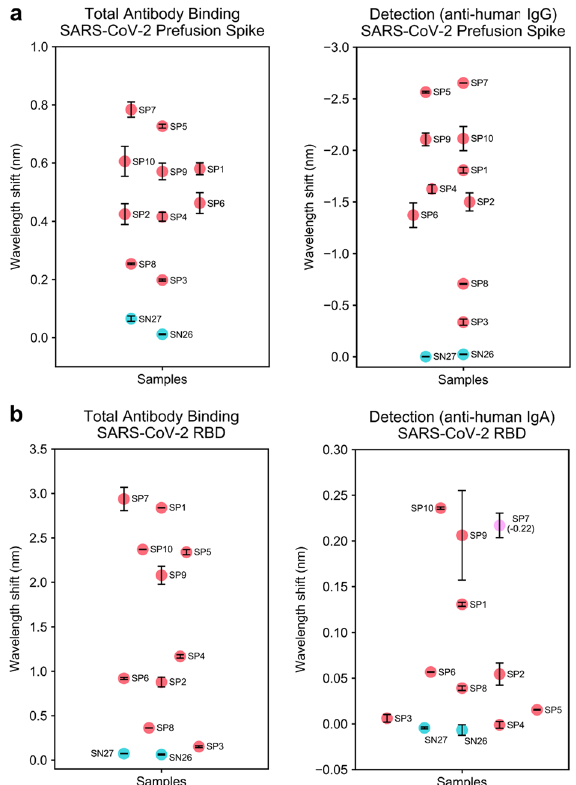
Figure 4. BLI-ISA evaluation of plasma antibodies to SARS-CoV-2 prefusion Spike and plasma IgA to SARS- CoV-2 spike RBD. ( a ) Single-dilution BLI-ISA to evaluate the presence of prefusion Spike-reactive human antibodies in the pre-pandemic seronegative (SN, cyan) and convalescent seropositive (SP, red) samples. The Total Antibody Binding signal (left) is measured when prefusion Spike-His-loaded HIS1K biosensors are dipped into plasma samples. The Detection signal (right) is measured when prefusion Spike-His-loaded HIS1K biosensors that had been dipped into plasma are subsequently dipped into colloidal gold-conjugated anti-human IgG. ( b ) Single-dilution BLI-ISA to evaluate the presence of RBD-reactive human antibodies in the samples. The Total Antibody Binding signal (left) is measured when RBD-biotin-loaded SA biosensors are dipped into plasma samples. The Detection signal (right) is measured when RBD-biotin-loaded SA biosensors that had been dipped into plasma are subsequently dipped into colloidal gold-conjugated anti-human IgA. The SP7 dot is colored pink to indicate that this sample had a negative signal (value in parentheses) in the Detection step. All assays were performed with plasma at a 1:8 dilution. Dots represent the mean of biological duplicates, and error bars represent one standard deviation from the